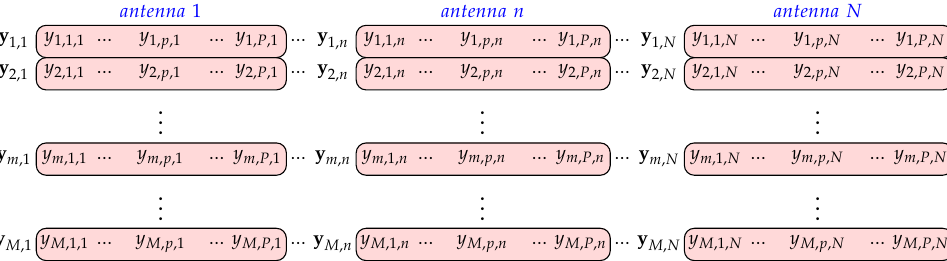
Figure 3. Three-dimensional matrix Y with complex signal samples ( M frames from N antennas) from the output of the dechirper.